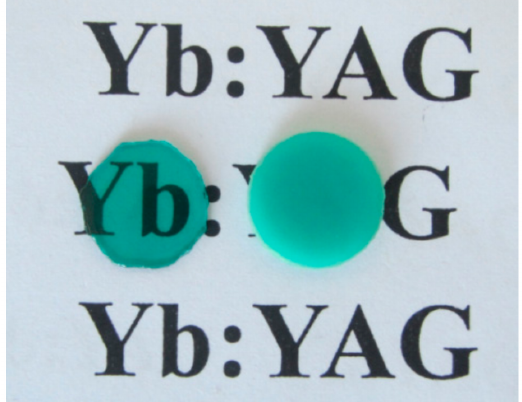
Figure 11. Photos of (Y 0.94 Yb 0.06 )AG transparent ceramics calcined at 1700 ◦ C, 5 h, the left: the ceramic of the precursor directly sintering; the right: the ceramic of the precursor laying aside a month and sintering at the same